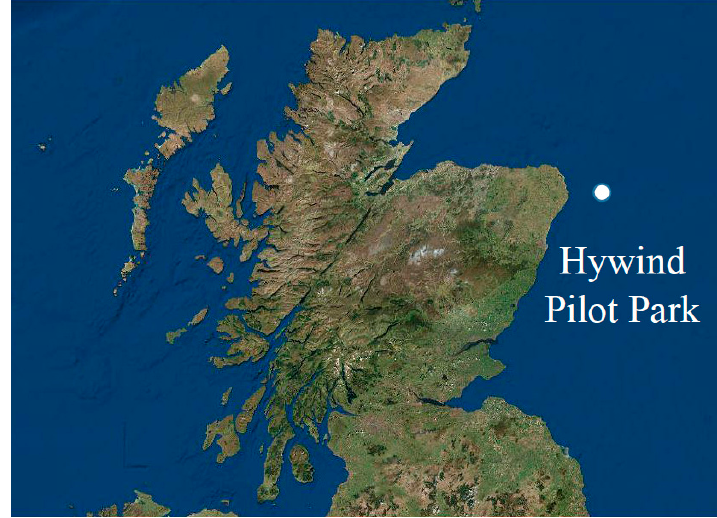
Figure 1. Location settings from NASA